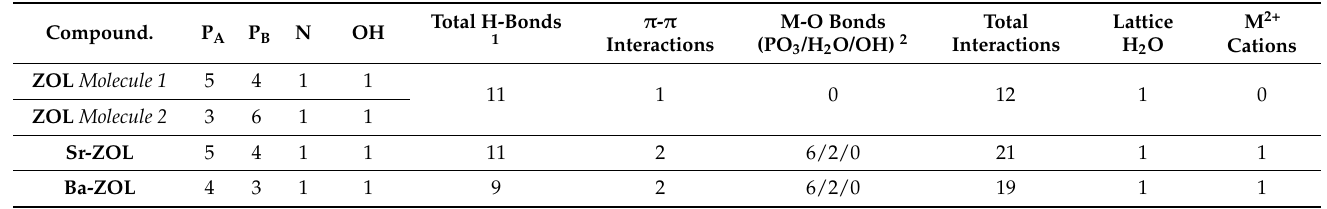
Table 2. All types of interactions present in the structure of ZOL acid monohydrate, Sr–ZOL and Ba–ZOL.